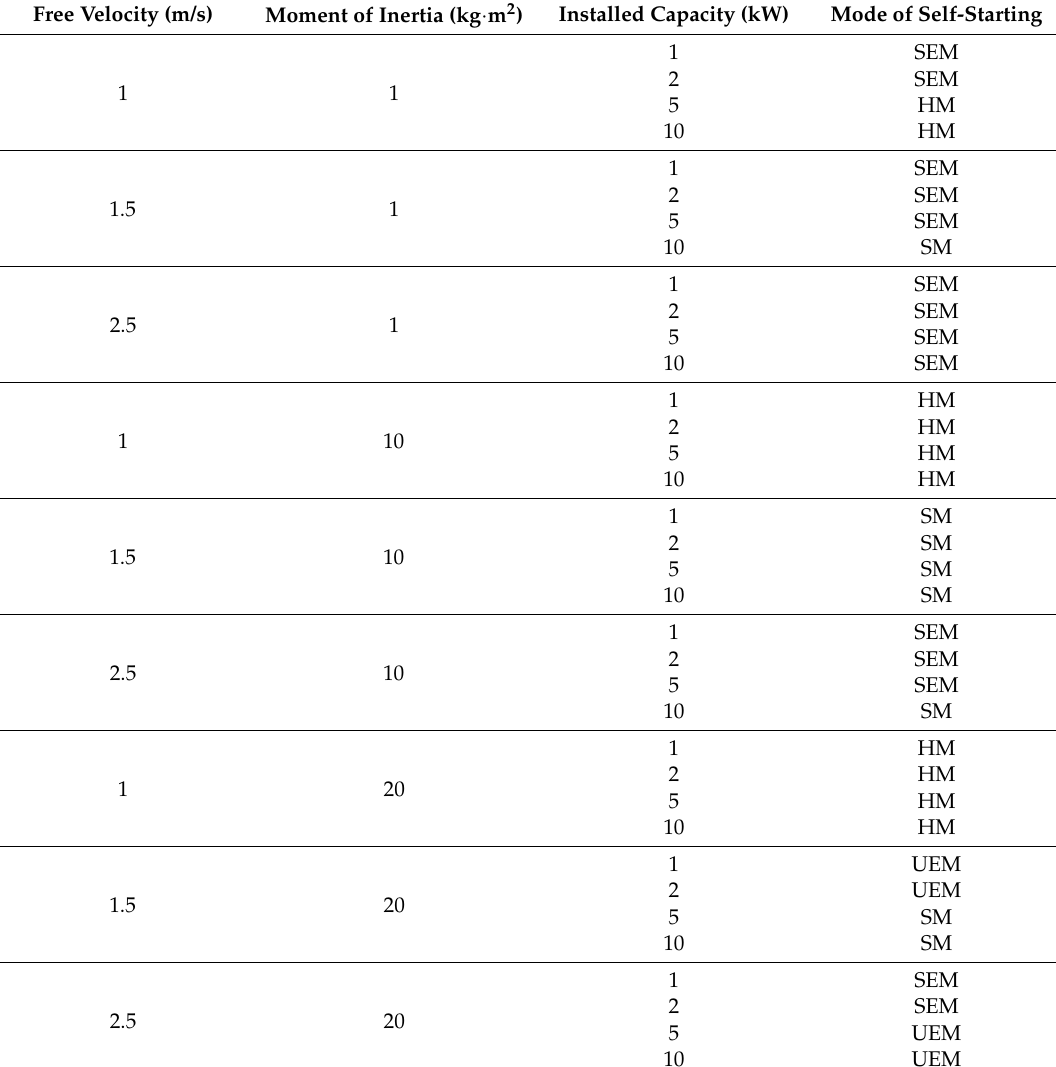
Table 3. Summary of self-starting